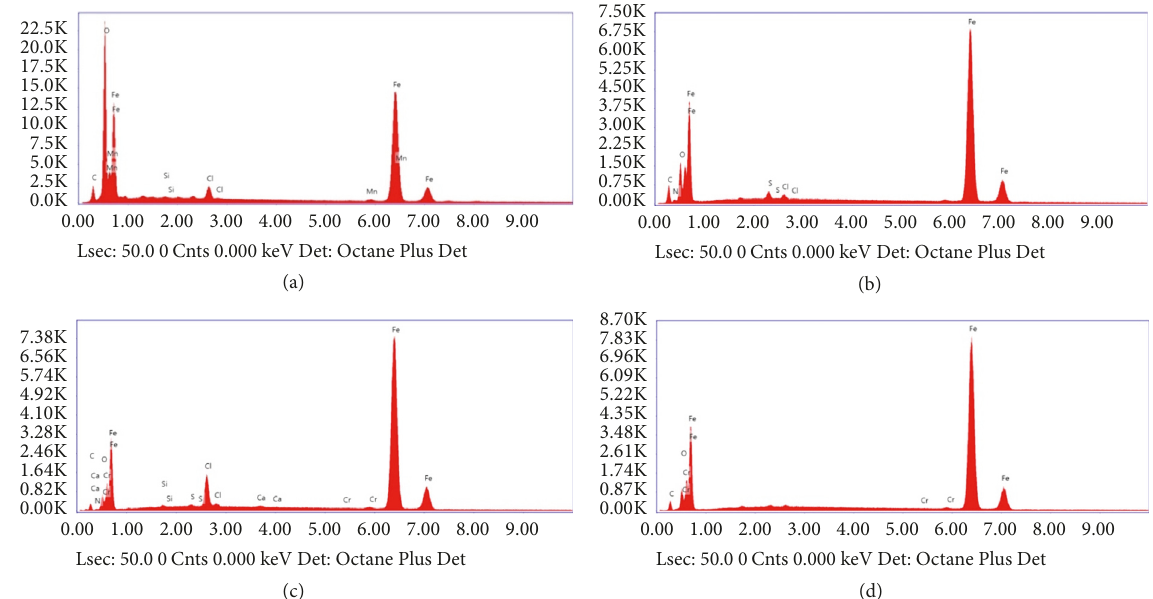
Figure 9: EDX spectra of steel specimens in the absence and presence of 5 mmol/L inhibitors (a) steel in 1MHCl (Blank), (b) steel in 1MHCl in the presence of inhibitor (5) , (c) steel in 1MHCl in the presence of inhibitor (6) , and (d) steel in 1MHCl in the presence of inhibitor (7) after 2 h of immersion at 293